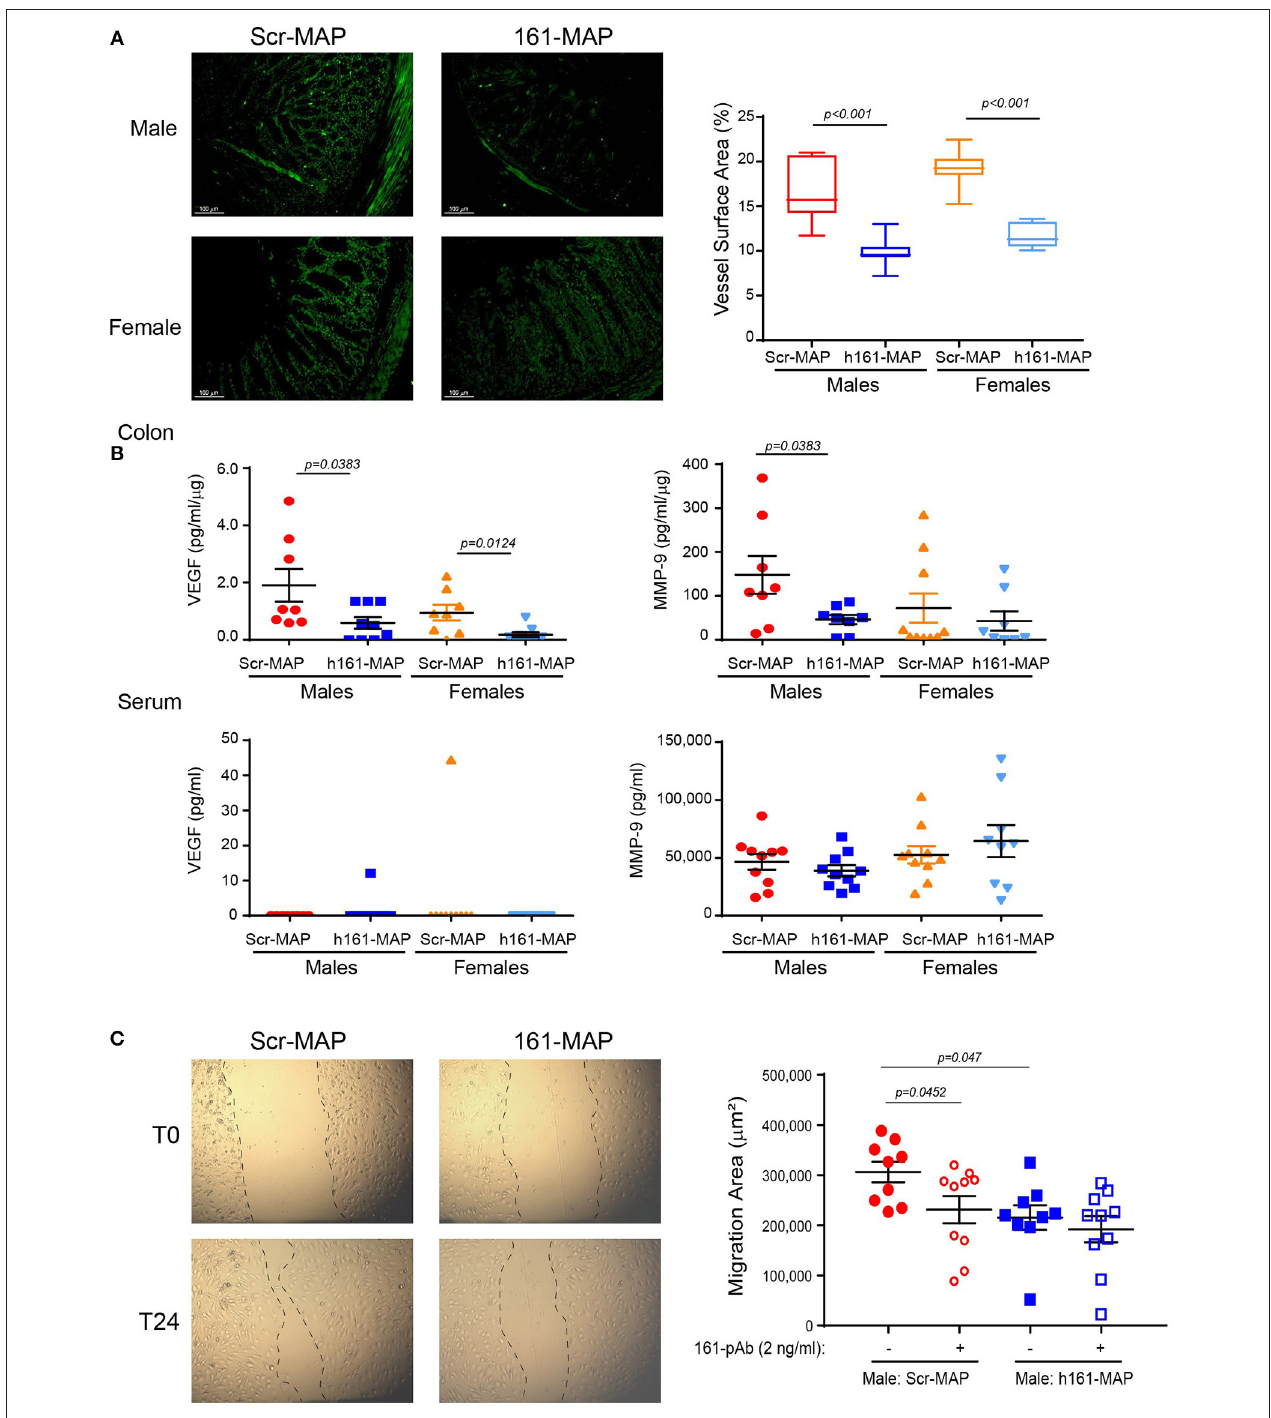
FIGURE 4 | 161-MAP active vaccination reduces angiogenesis. (A) Colon sections were stained for CD31 and the vessel surface area was calculated ( n = 4 per group). Scale bar is 100 µ m. (B) Concentrations of VEGF and MMP-9 were determined in serum sample by ELISA, and in the colon lysates, normalized to the total protein amounts ( n = 9 per group). (C) Wound scratch assay: colon lysates (25 µ g of total protein) were diluted (1:4) and applied onto a confluent layer of the mouse bEND3 endothelial cells (10 5 cells/ 96-plate well) that was scratched with a toothpick. Images were acquired at the beginning of the experiment (T0) and at the end after 24h (T24). The migration area was calculated by subtracting the area of the wound at T24, after endothelial cell migrated and partially closed the wound, from the area of the wound at T0. An EMMPRIN specific blocking antibody (161-pAb) was added to some of the wells as indicated. ( n = 9–10 for the male mice, n = 8 for the female mice). Magnification is